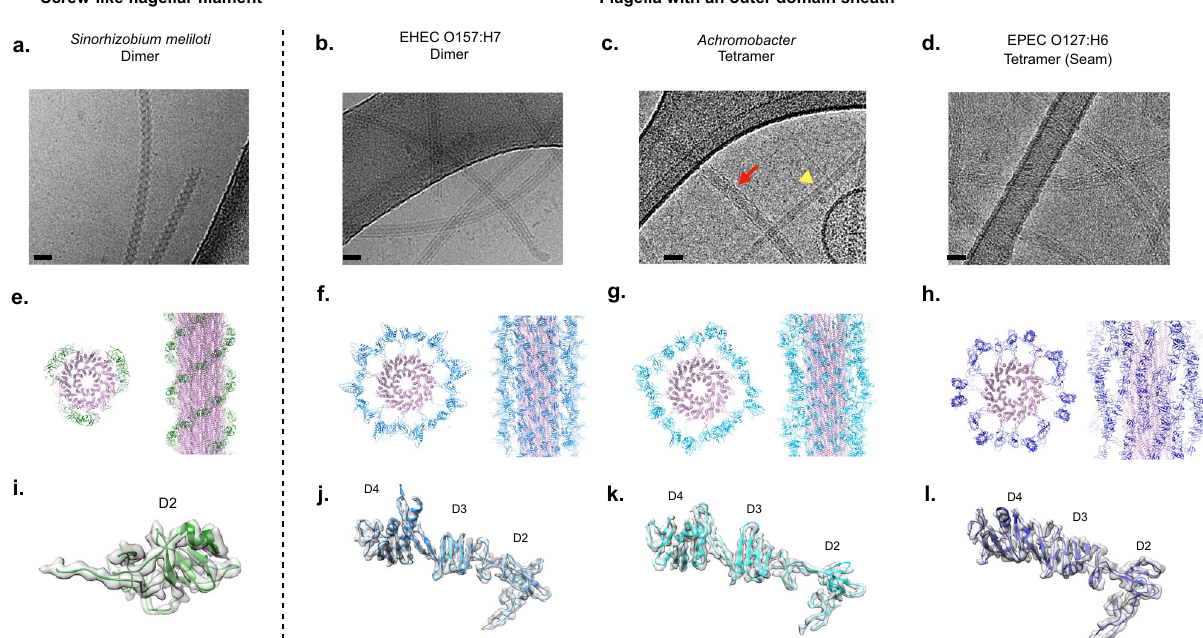
Fig. 1 Cryo-EM structure of outer-domain sheath and screw-like fl agellar fi laments. a – d Cryo-electron micrographs of S. meliloti ( a ), EHEC H7 ( b ), Achromobacter ( c ), and EPEC H6 ( d ) fl agellar fi laments. The scale bar in each micrograph is ~20 nm. In c , the red arrow points to an Achromobacter fl agellar fi lament. The yellow triangle indicates an Agrobacterium tumefaciens fl agellar fi lament. Scale bar is 200 Å. Atomic models of the S. meliloti ( e ), EHEC H7 ( f ), Achromobacter ( g ), and EPEC H6 fl agellar fi laments ( h ). The conserved D0/D1 core domains are shown in pink. Outer domains are colored green for the screw-like fl agellar fi lament ( e ) and various shades of blue for those with an outer-domain sheath f – h . Models and density maps for the single outer domain (D2) of S. meliloti ( i ), and for the three outer domains (D2, D3, D4) of EHEC H7 ( j ), Achromobacter ( k ), and EPEC H6 ( l